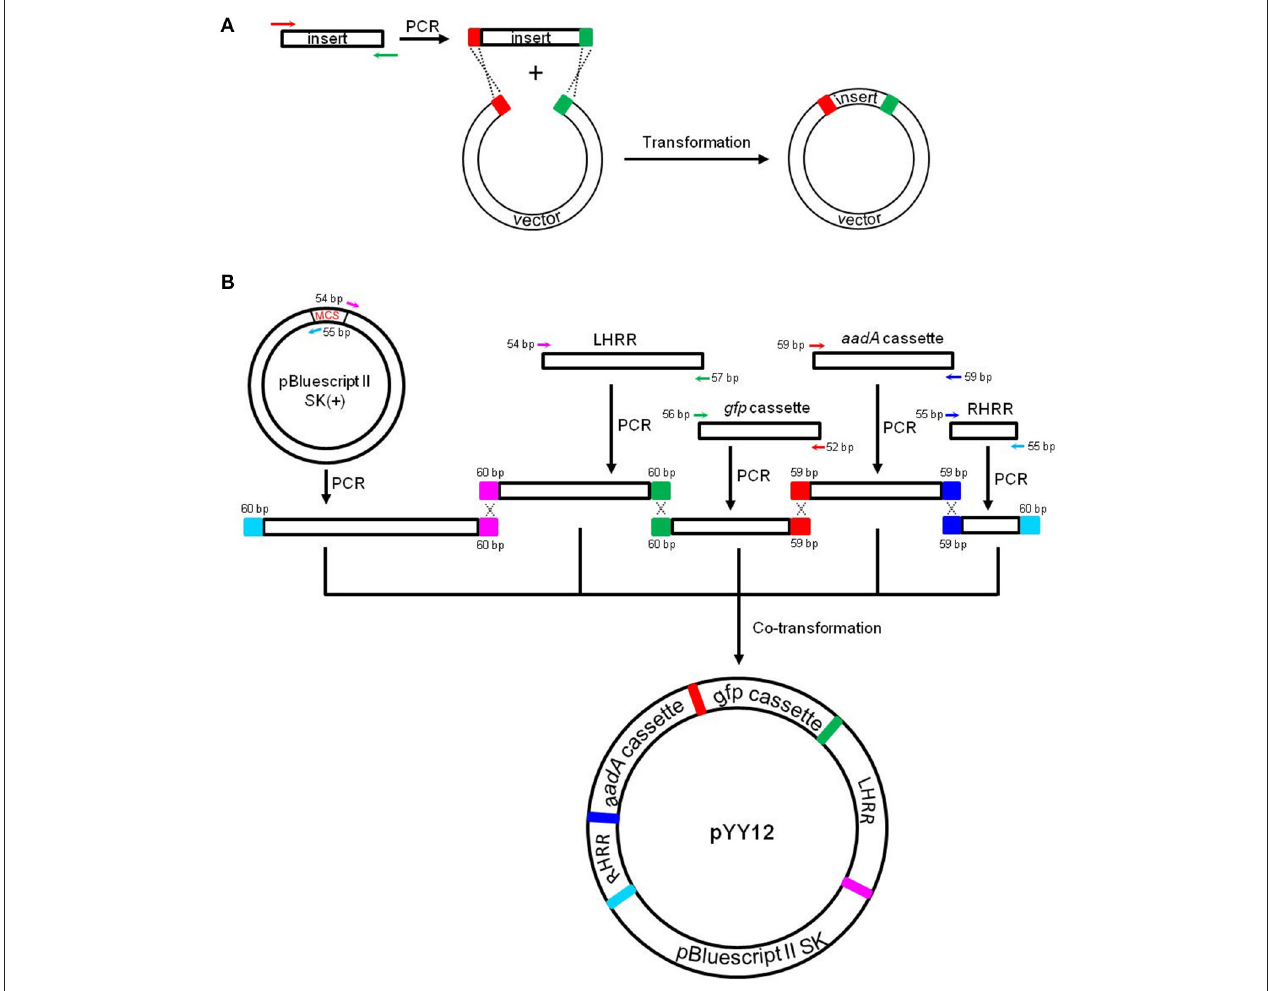
FIGURE 1 | Principles of the in vivo E. coli cloning (iVEC) method and its application for the construction of plastid transformation vectors. (A) Schematic representation of iVEC illustrating integration of one insert into a cloning vector using the endogenous homologous recombination machinery of E. coli . (B) iVEC strategy for generation of plastid transformation vector pYY12. Five PCR products comprising the four DNA inserts (LHRR, RHRR, aadA, and gfp expression cassettes) and the linear backbone fragment (SK), pairwise sharing homologous sequences (59–60 bp) at their ends, were co-transformed into E. coli . LHRR, left homologous recombination region; RHRR, right homologous recombination region. Boxes of the same colors indicate the homologous sequences. Note short primer pairs with overlap at their 3’ ends can generate PCR products with longer homologous end